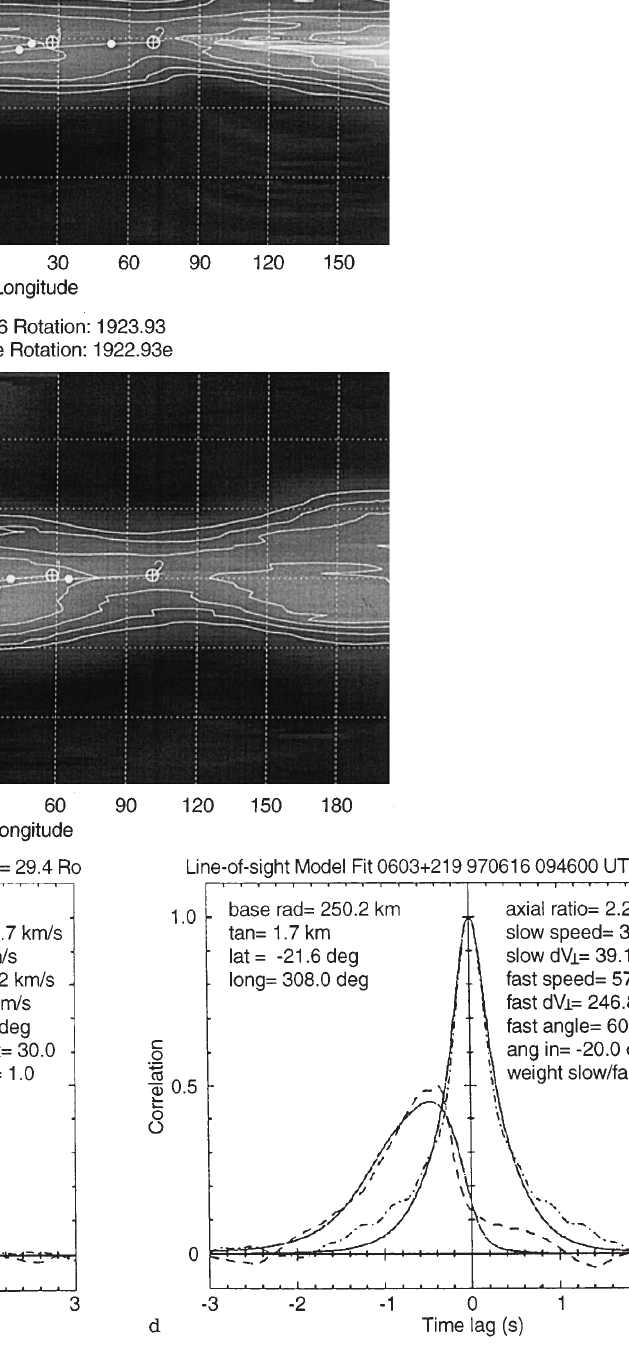
Fig. 10. a White-light coronal map centred on 22 May 1997. The lines superimposedonthemaprepresenttheIPSray-pathforanobservation of 0431+206, projected down to 1.7 R with assumed velocities of 750 km s ) 1 (line 1) and 325 km s ) 1 (line 2). b White-light coronal map centred on 16 June 1997. The lines superimposed on the map represent the IPS ray-path for an observation of 0603+219, projected down to